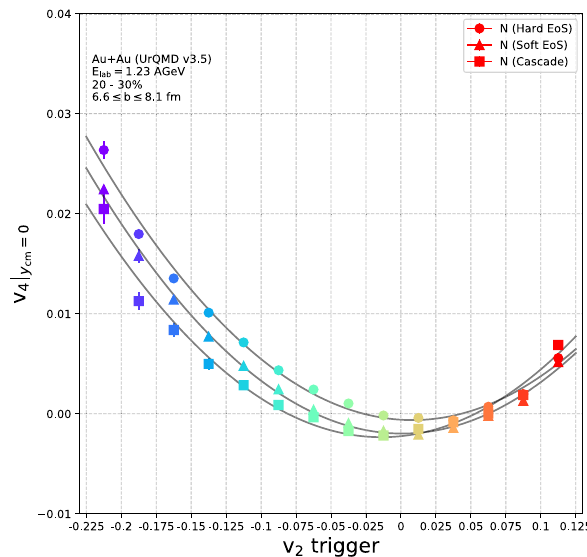
Fig. 5 The slope of the triangular flow component v 3 of nucleons at y cm = 0 as a function of the final state elliptic flow v 2 (colored full sym- bols) integrated over − 0 . 5 ≤ y cm ≤ 0 . 5 for a hard EoS (circles), a soft EoS (triangles) and in cascade mode (squares) from 20–30% peripheral Au+Au collisions at 1.23 AGeV from UrQMD